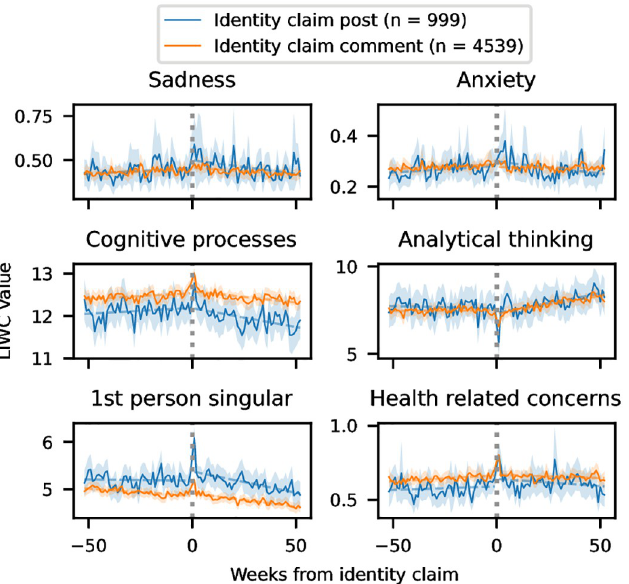
Fig 2. LIWC changes over time for users whose identity claims are in the form of posts and comments. Analytical thinking is computed based on other categories; the other y axes are percentage of total words. The solid line marks the weekly mean values; the dashed line shows the trend lines for the before and after periods, and the shaded area covers the 95% confidence